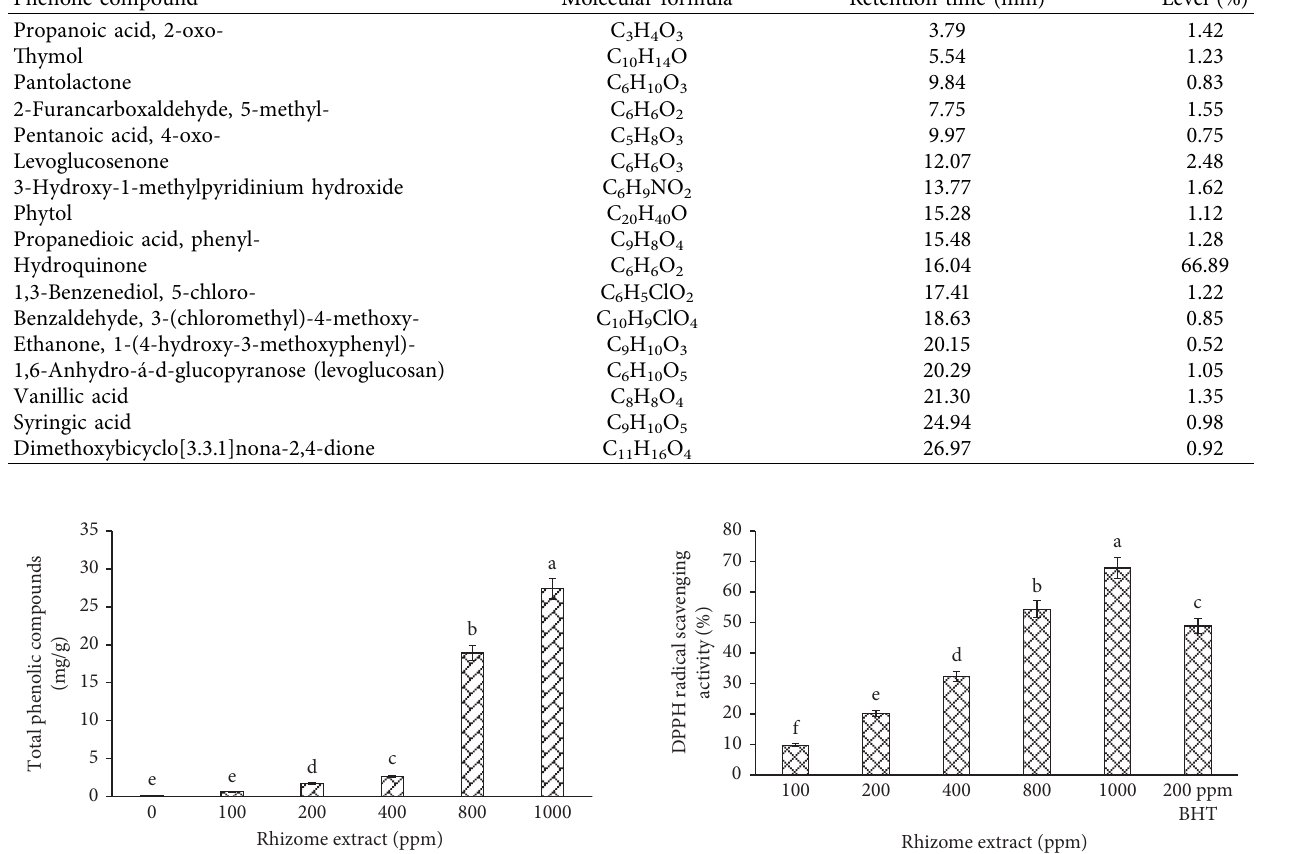
Table 4: Phenolic compounds identified in the methanolic extract of C. dactylon rhizomes. Phenolic compound